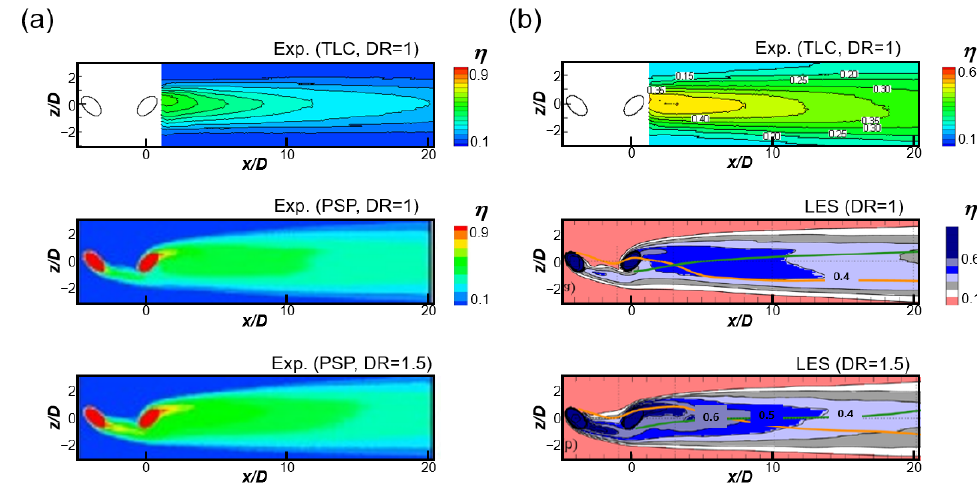
Figure 10. Double-jet film-cooling effectiveness distributions: ( a ) M = 0.5 and ( b ) M = 1.0.